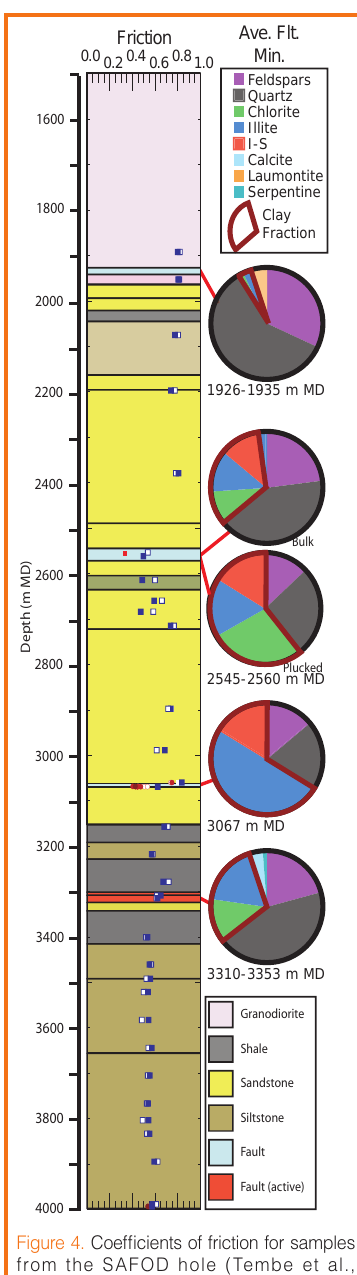
Figure 4. Coefficients of friction for samples from the SAFOD hole (Tembe et al., submitted). Average fault rock mineral assemblages are shown at right (Solum et al., in review). Lithologies are from Boness and Zoback